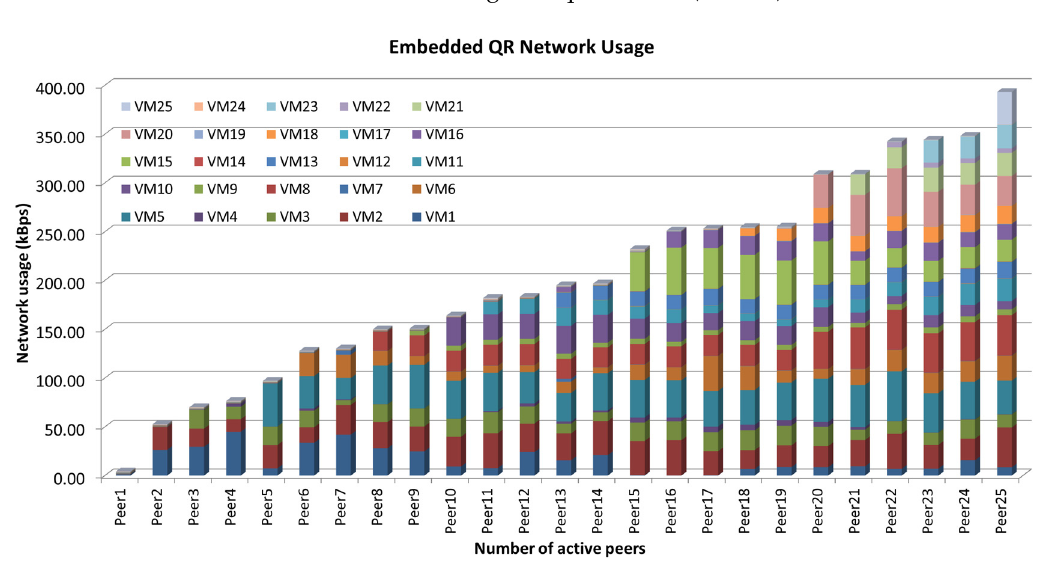
Figure 17. Average bandwidth utilization (inbound and outbound) per peer on a network of N = 25 peers.